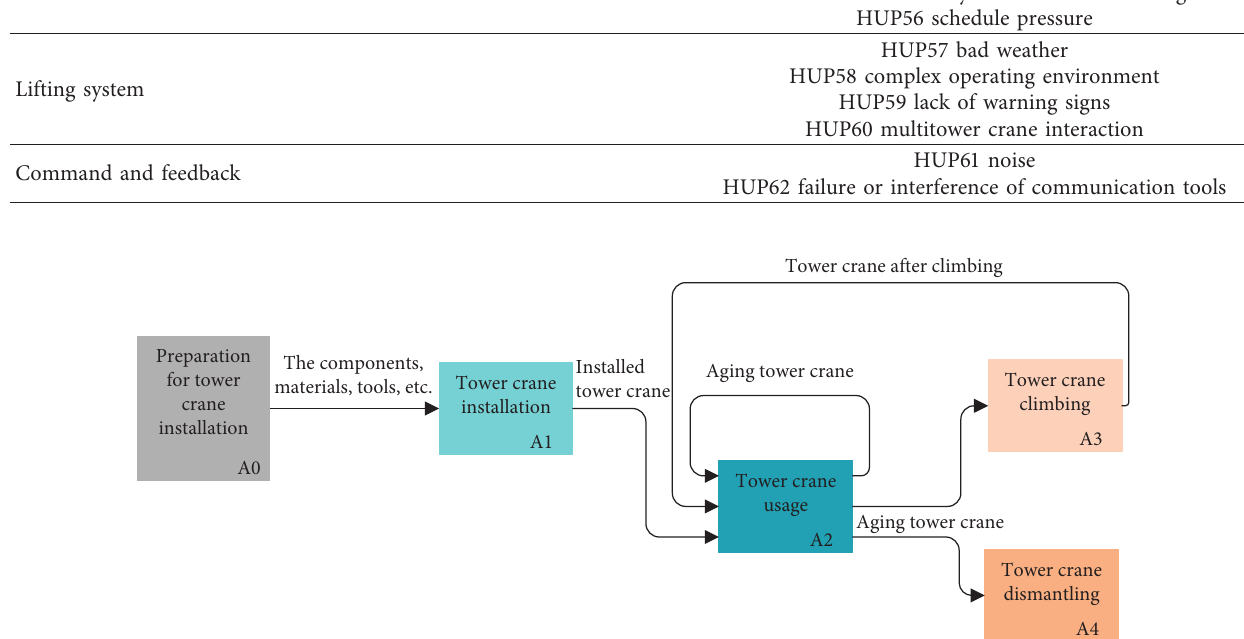
Figure 9: System inputs and outputs of each